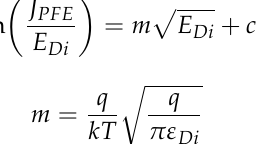
Figure 7. Gate leakage characteristics of the Al 2 O 3 /SiO 2 MOS – HEMT with and without PGA treat- ment and conventional HEMT without PGA treatment.